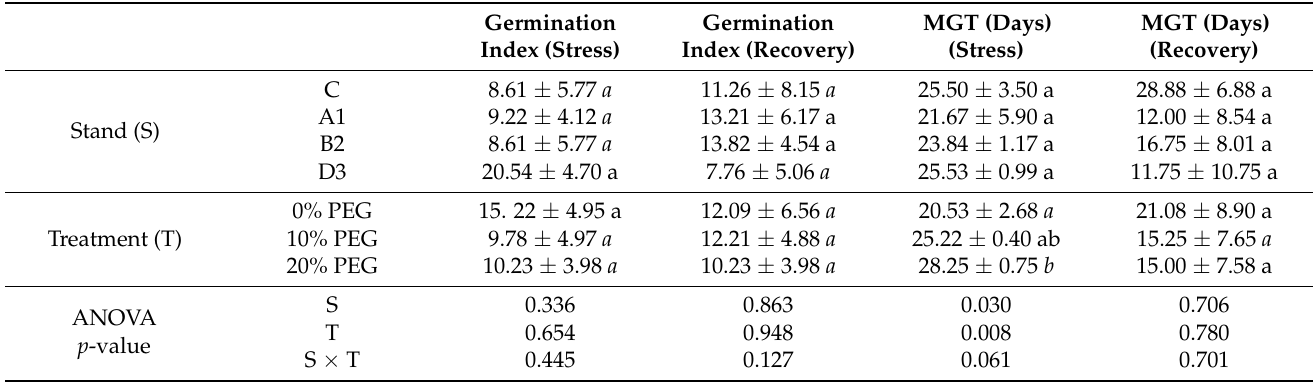
Table 3. Mean ( ± standard error, S.E.) values of germination index and mean germination time (MGT) during the stress and recovery periods per stand (S), as well as PEG treatment